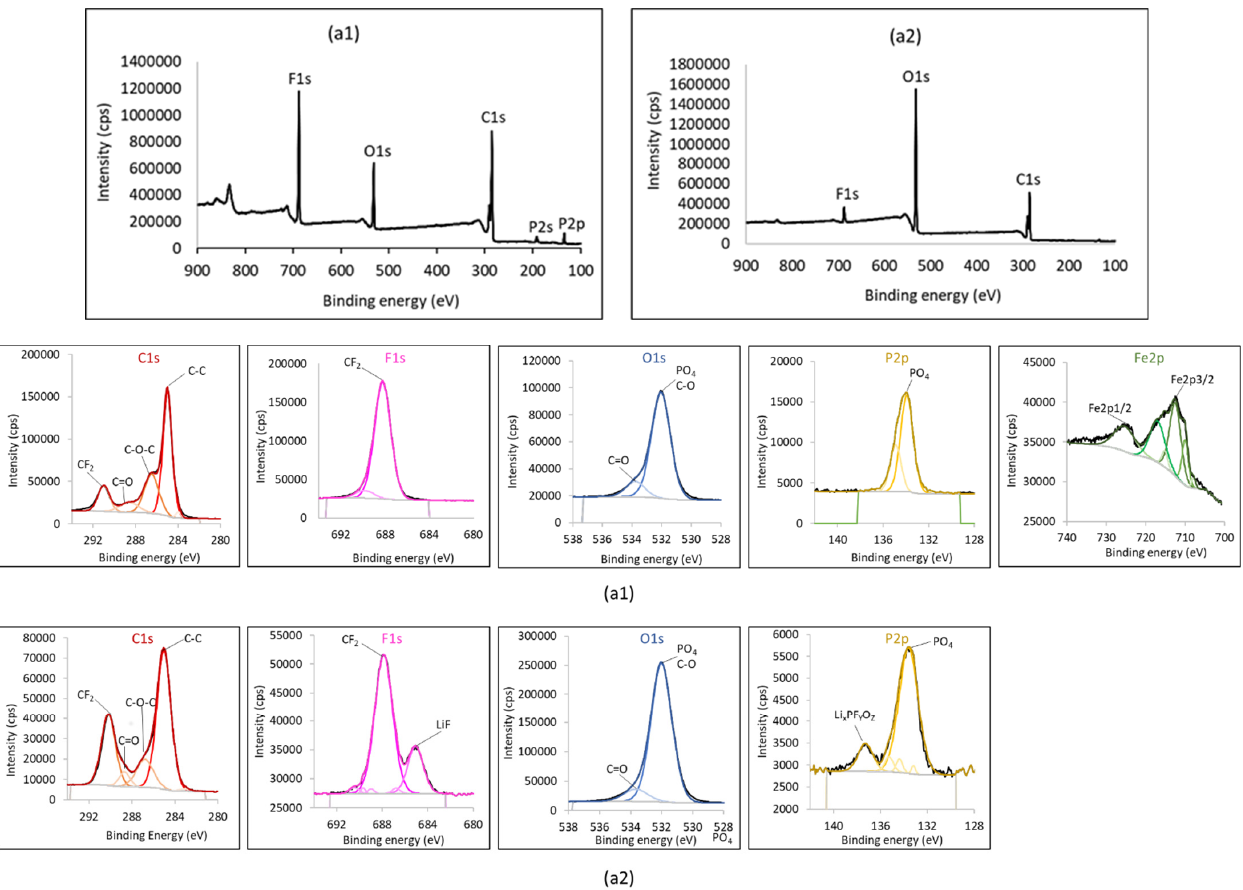
Figure 3. XPS spectra of the LFP cathode coating with PVDF binder: ( a1 ) as prepared and ( a2 ) postmortem after 25 battery cell cycles.